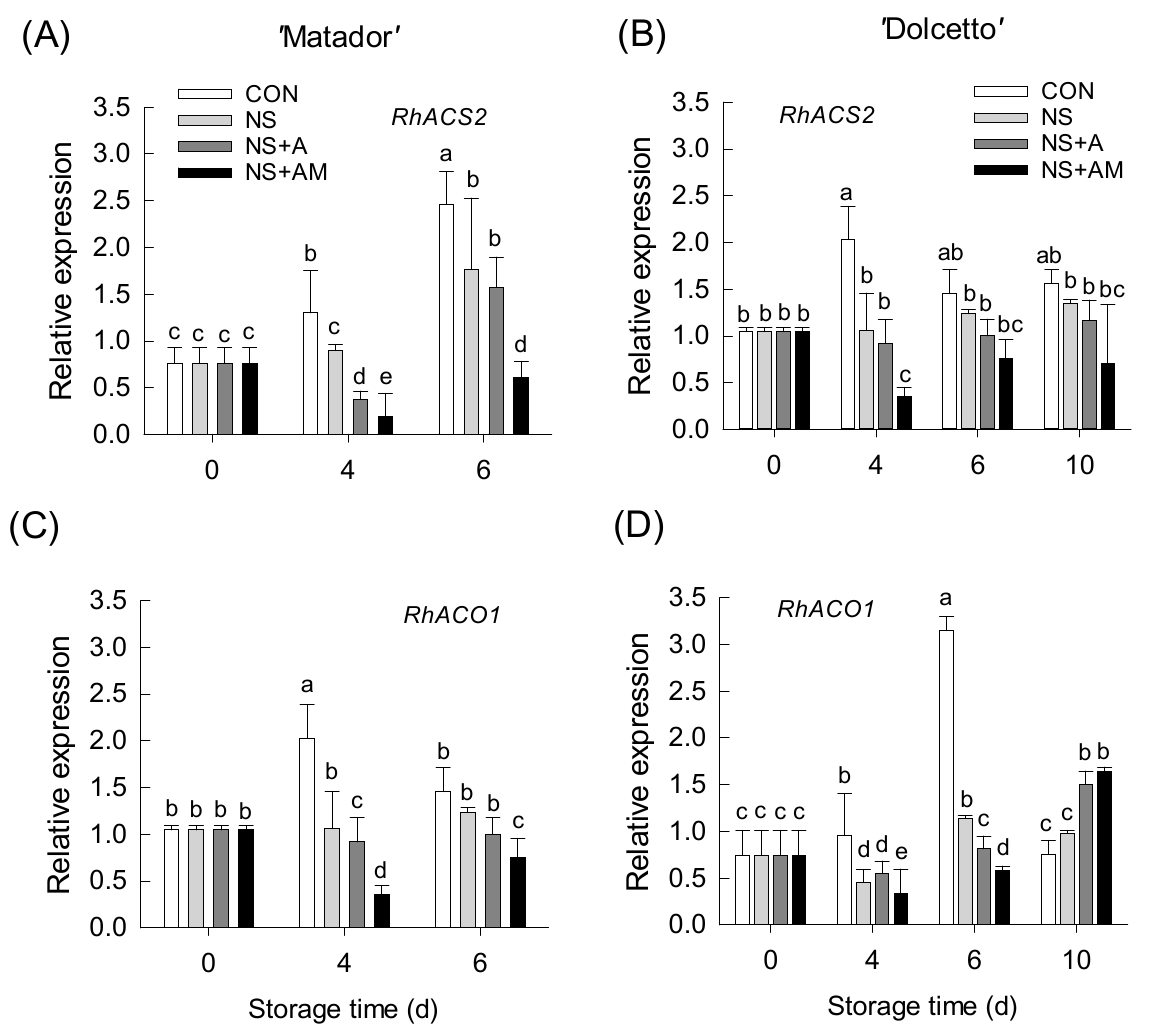
Figure 4. Expression levels of ethylene biosynthesis genes ( RhACS2 and RhACO1 ) in ‘Matador’ ( A , C ) and ‘Dolcetto’ ( B , D ) cut roses. mRNA levels of RhACS2 and RhACO1 were detected in petals on day 0 (before ethylene treatment) and on days 4, 6, and 10 after ethylene treatment. CON, control flowers were held in DW; NS, cut roses were treated with nano silver; NS+A, cut roses were treated with NS and AIB; NS+AM, cut roses were treated with NS, AIB, and 1-MCP. All cut roses were exposed to ethylene (2 µL L − 1 ) for 24 h at 25 ± 1 °C under dark conditions. Different letters above bars show statistically significant differences among treatments at p < 0.05 based on DMRT. Vertical bars indicate SE of the means ( n = 3).